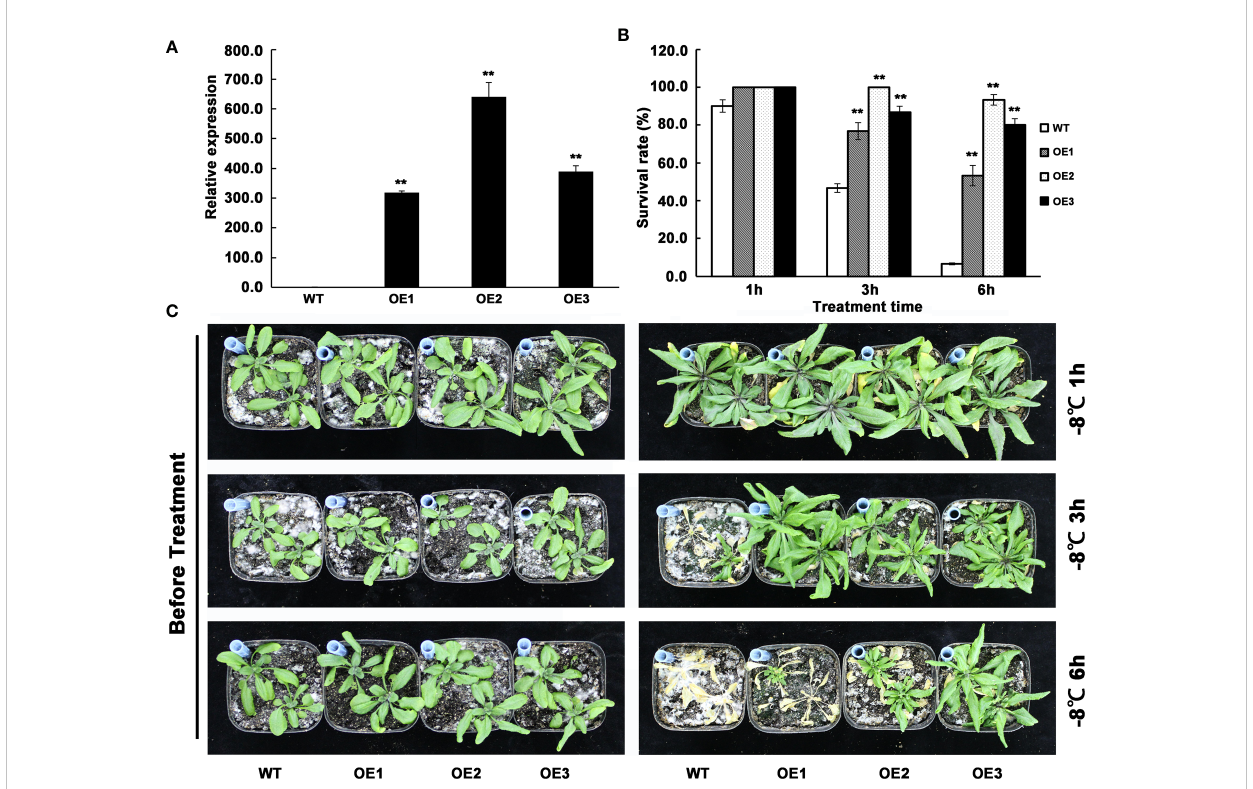
FIGURE 3 Detection of AhMYB30 transgenic Arabidopsis plants and phenotype observation of the transgenic plants under freezing stress. (A) , quantitative fl uorescent PCR analysis of AhMYB30 expression in wild type controls (WT) and three independent transgenic lines of Arabidopsis (OE1, OE2, and OE3). Arabidopsis Actin2 transcript was ampli fi ed as a control; (B) , Quantitative analysis of the plant survival rate 14 d after the freezing treatment as shown in (C) . Error bars indicate standard deviation (SD), which was calculated using results of three replicated experiments. Asterisks indicate a signi fi cant difference (** p < 0.01) compared with the corresponding controls; (C) , Phenotype of wild-type (WT) and AhMYB30 -overexpressed plants after freezing stress. Twenty-day-old WT and transgenic plants were freezing stressed at -8°C for 1, 3, and 6 h and then transferred back to the normal condition for